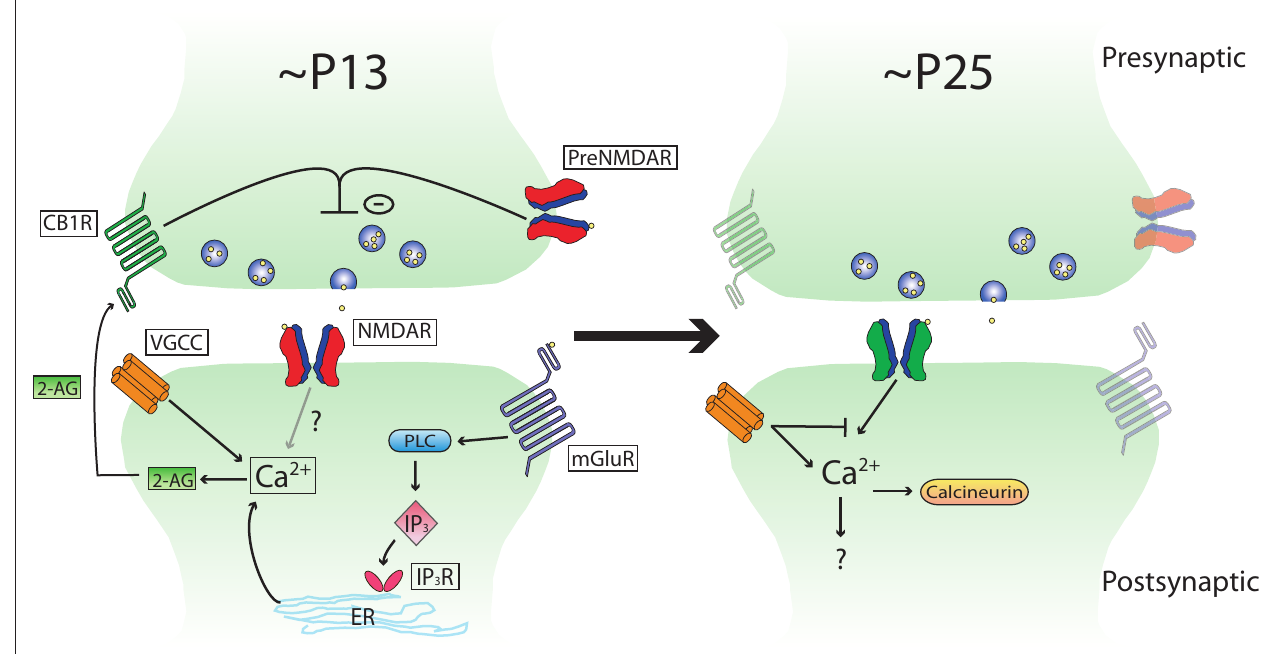
FigurE 1 | Schematic depicting developmental changes in known tLTD induction mechanisms at L4–L2/3 synapses in rodent sensory neocortex. Note that the mechanisms are very similar between the different sensory areas, and that this scheme could apply to primary visual cortex as well as primary somatosensory cortex (see text for